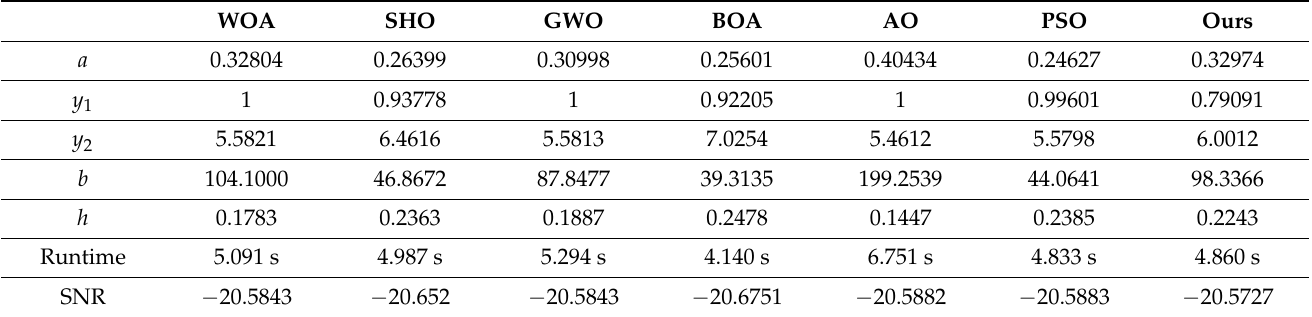
Figure 11. The output signal processed by the mentioned method: ( a ) WOA, ( b ) SHO, ( c ) GWO, ( d ) BOA, ( e ) AO, ( f ) PSO. Table 5. Experimental parameter